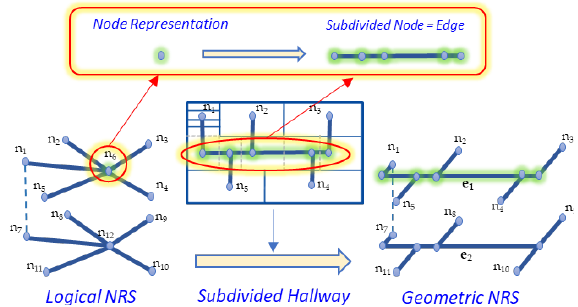
Figure 2. Representation of indoor space relationships using the Geometric